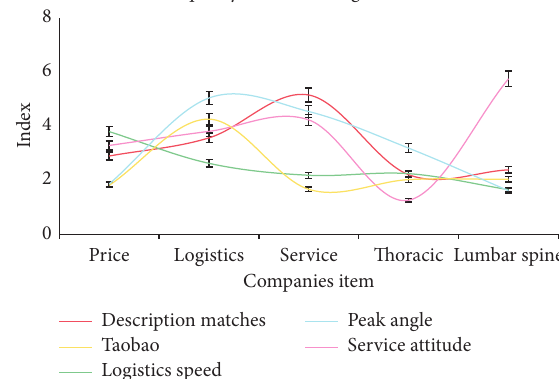
Figure 1: The quality of business logistics services.